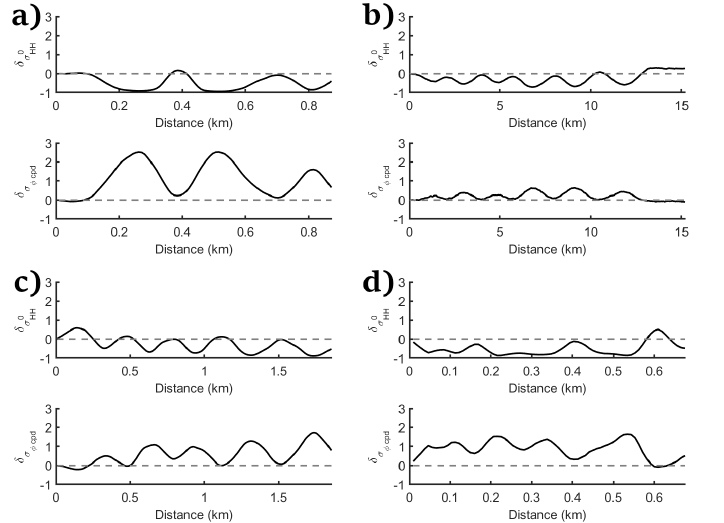
Figure 6. δ and δ σ profiles (upper and lower, respectively) associated to: ( a ) Image ID 3; ( b ) σ 0 HH φ CPD Image ID 5 (Profile ID 5.2); ( c ) Image ID 8; and ( d ) Image ID 9 (Profile ID 9.2). The dotted green lines show the δ = 0; where l = l 0